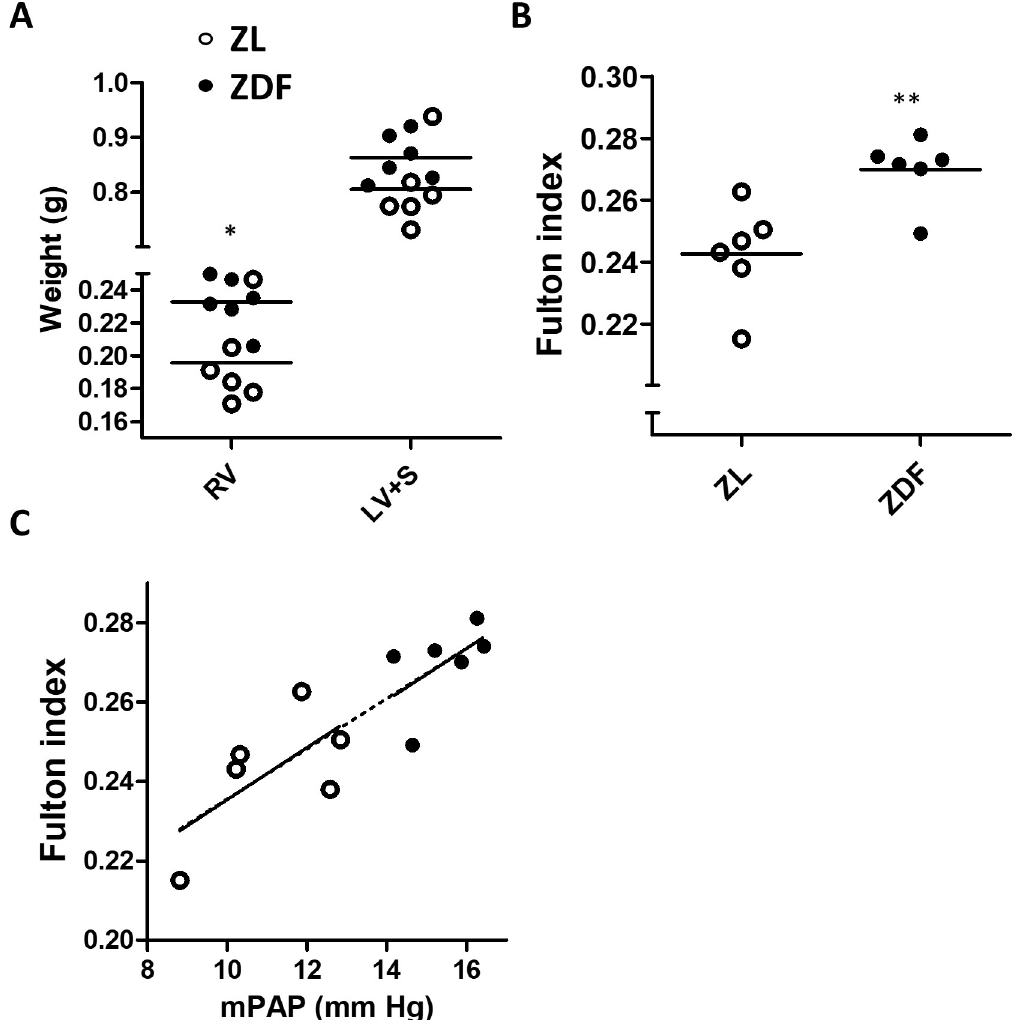
Fig 2. ZDF rats show right ventricular hypertrophy. (A) Right ventricular (RV) weight and left ventricular plus septum (LV +S) weight as absolute values and (B) Fulton index [RV/(LV+S) ratio]. (C) Correlation between mPAP and Fulton index. The dotted line represents the linear regression for pooled data from both groups (r 2 = 0.72, p < 0.001. Results are expressed as scatter plots and means of 6 animals, � , �� and ��� indicate P < 0.05, P < 0.01 and P < 0.001, respectively, ZDF versus ZL (unpaired t